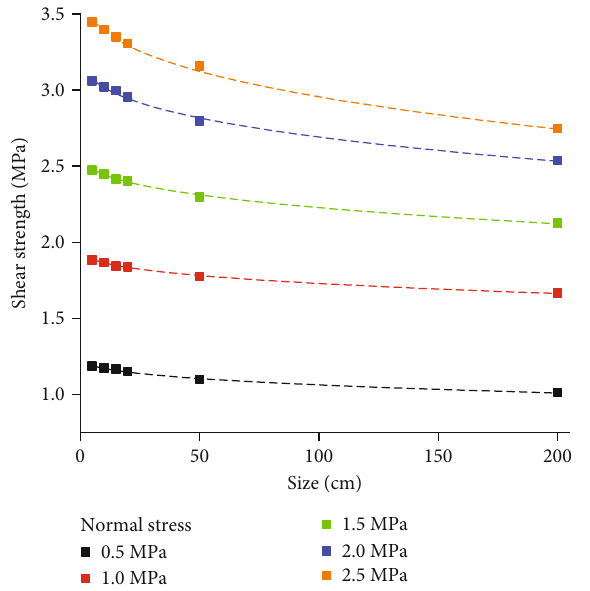
Figure 12: Relationship between model size and shear strength of anchored through-type joint subjected to di ff erent normal stress. Table 6: Parameter fi tting results of power function equation. Fitting parameters